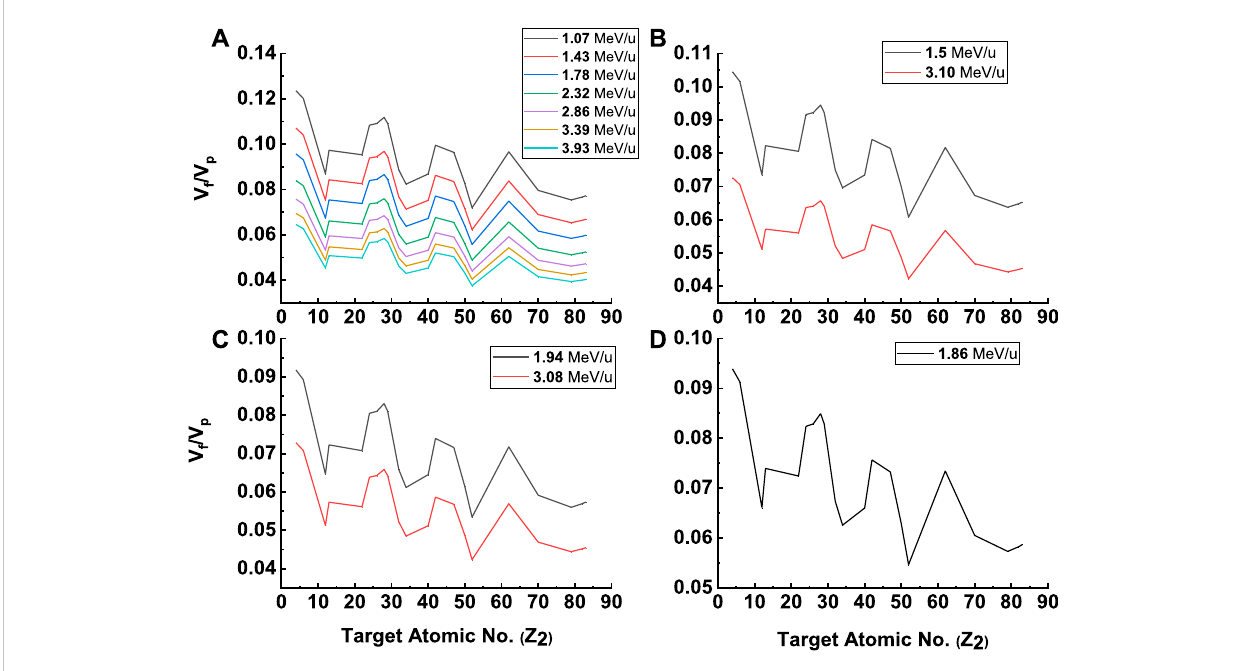
FIGURE 4 Z 2 dependenceofFermivelocitieswithrespecttoprojectilevelocities: (A) Siasprojectile, (B) Fasprojectile, (C) Clasprojectile,and (D)